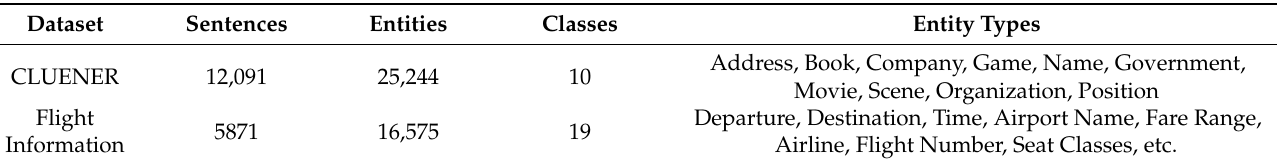
Table 1. Source domain dataset.